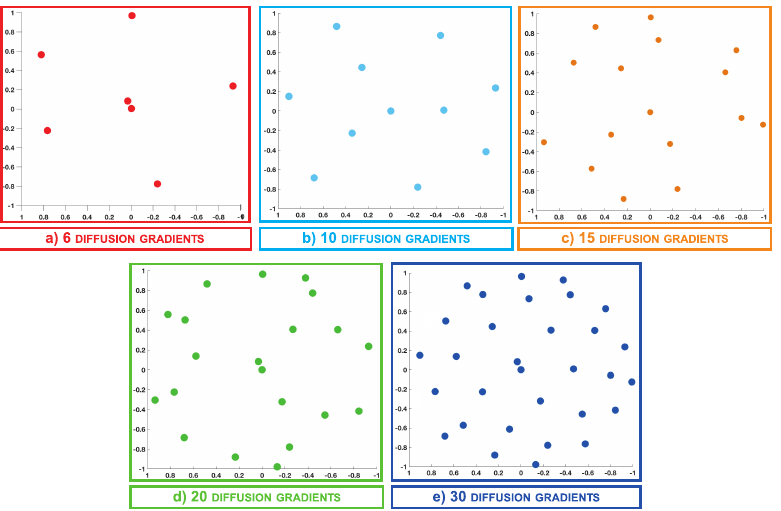
Figure 2. Equatorial plane projection of the q-space under-sampling schemes considered for the synthetic data acquired with 6 ( a ), 10 ( b ), 15 ( c ), 20 ( d ) and 30 ( e ) diffusion gradients.